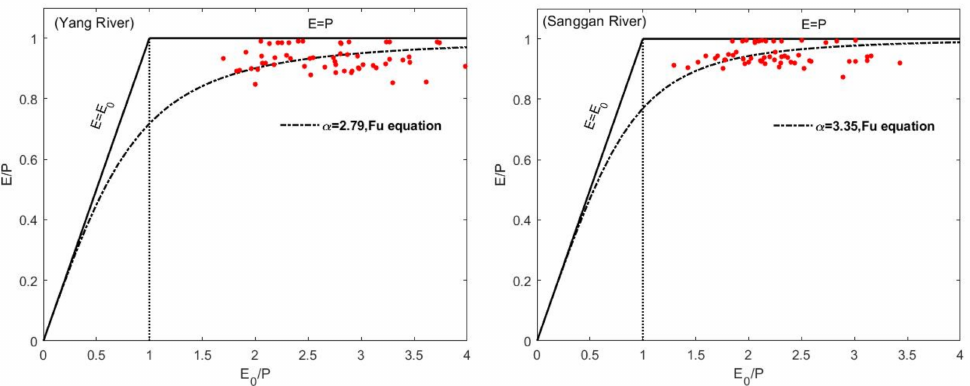
Figure 2. Budyko curve showing the relation between ε (ratio of E a to P) as a function of ϕ (E 0 /P) in the YRB and SRB. The bold black lines serve as an envelope (energy limit and water limit) to the Budyko curve family. The curve corresponds to α = 2.79 and α = 3.35 for YRB and SRB,